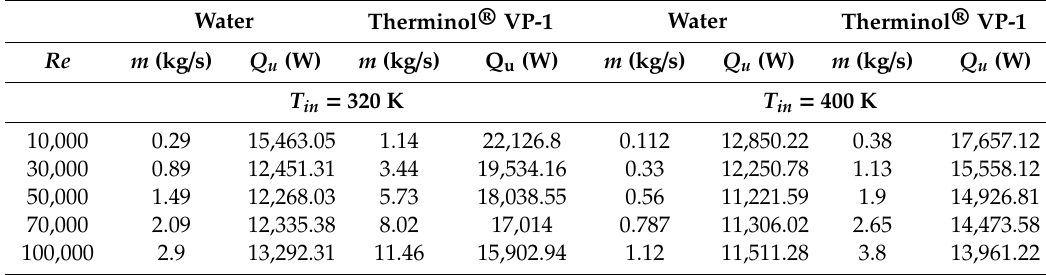
Table 8. A comparison between the thermal performances of water and Therminol ® VP-1. Water Therminol ® VP-1 Water Therminol ®